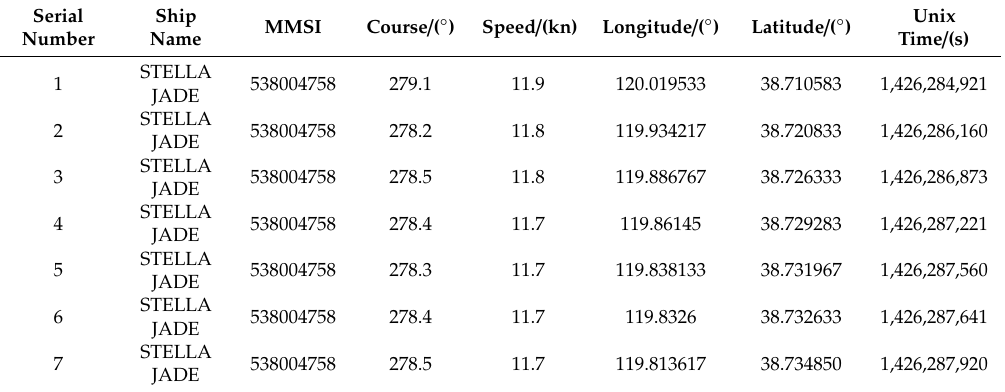
Figure 3. Ship trajectory with sample data sets. The purple line refers to the Automatic Identification System (AIS) trajectory of ship. The purple hollow circle refers to the trajectory point of the selected trajectory segment and the arrow indicates the ship’s navigation direction. Input t i refers to the trajectory point of the current t i time and the past three times (t i − 1 , t i − 2 , t i − 3 ) as the input data of the model and output t i refers to the trajectory of the next time t i+1 The point is used as the output data of the model; Input t i+1 refers to the track point of the t i+1 time and the past three times (t i , t i − 1 , t i − 2 ) as the input data of the model and the output t i+1 means The track point of t i+2 at the next moment is used as the output data of the model. Table 2. Sample data structure.